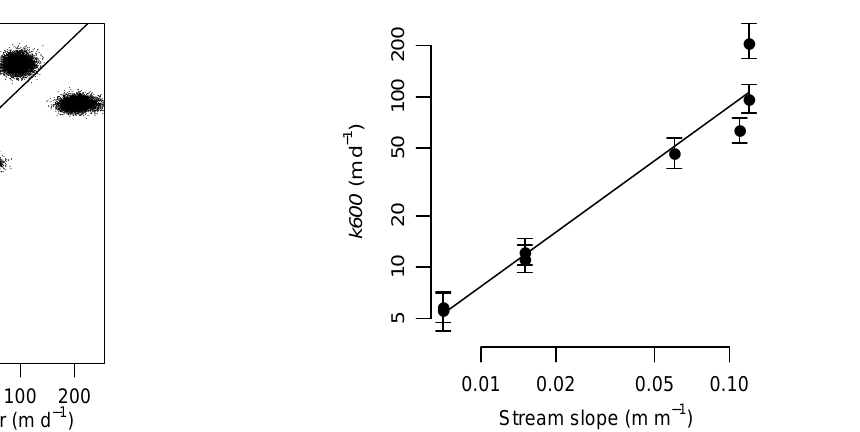
Figure 3. k 600 measured from SF 6 was lower than predicted from k 600 measured from argon in six of the eight injections. Each injec- tion is represented by a cloud of points that represents 6000 draws from the posterior distributions of k j and a j , from which we calcu- lated gas exchange velocity ( k ) following Eq. (8) and converted to k 600 using Eq. (1). Line is 1 : 1. Note log-scaled axes.